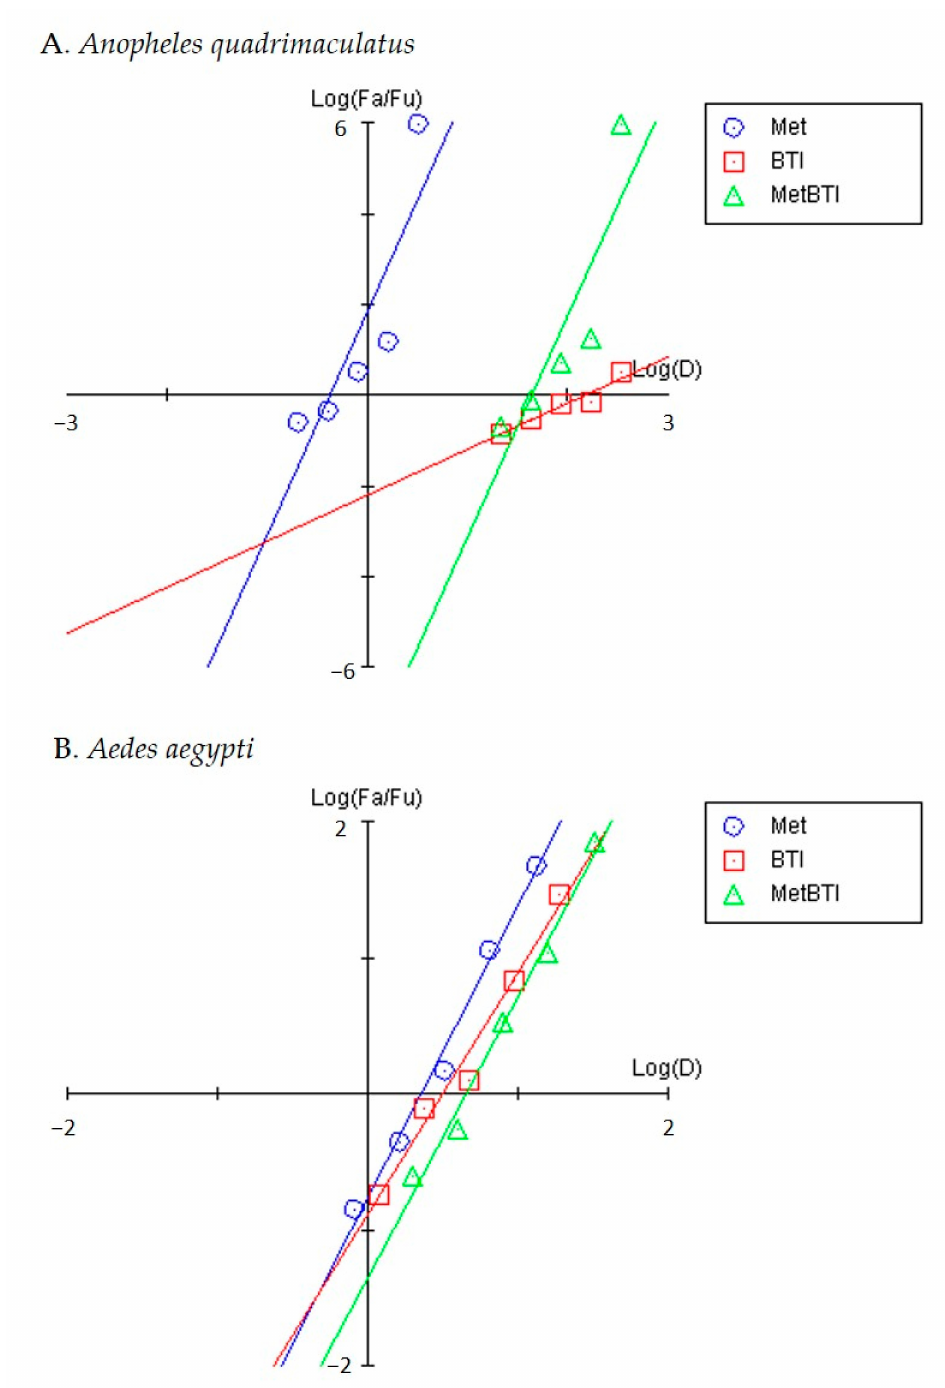
Figure 3. Median e ff ect plots for Anopheles quadrimaculatus (( A ), n = 4) and Aedes aegypti (( B ), n = 6) for DL-methionine (Met; g / L) and Bacillus thuringiensis subspecies israelensis (BTI; µ g / L) alone and in combination (MetBTI; no units). Exposures occurred over 48 h in glass jars. Ordinate values represent log of the lethality fraction (log( f a / f u )) a ff ected by the concentration at various abscissa log concentrations (log(D)). Each data point represents the average mortality in all replicates. Plotted using the software Compusyn